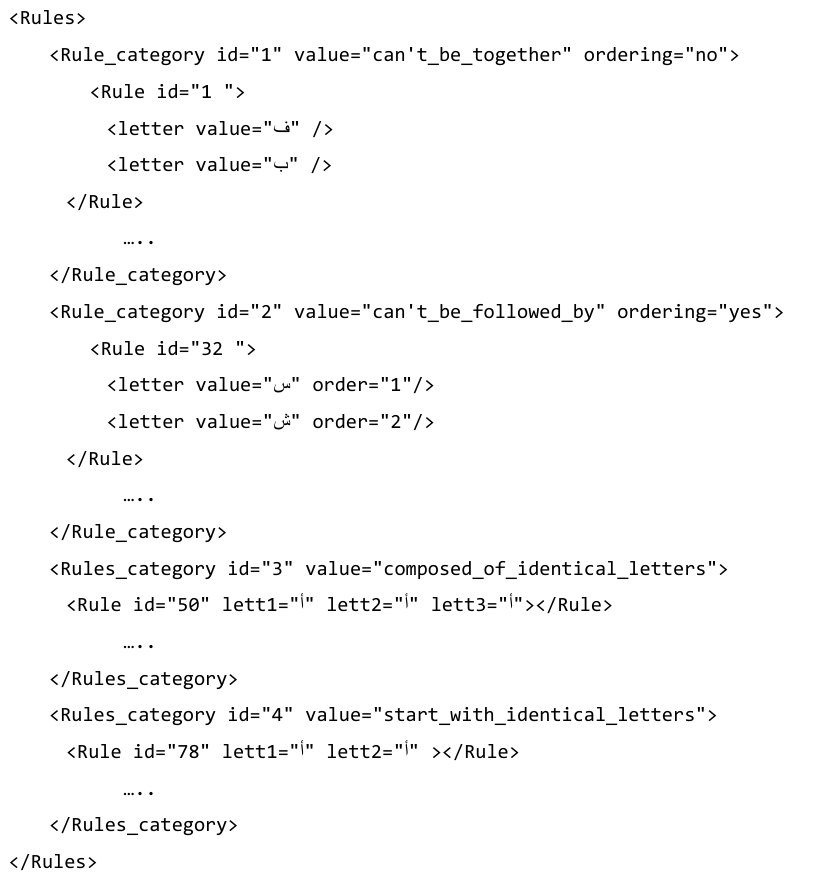
Figure 3. Phonetic rules XML file example.